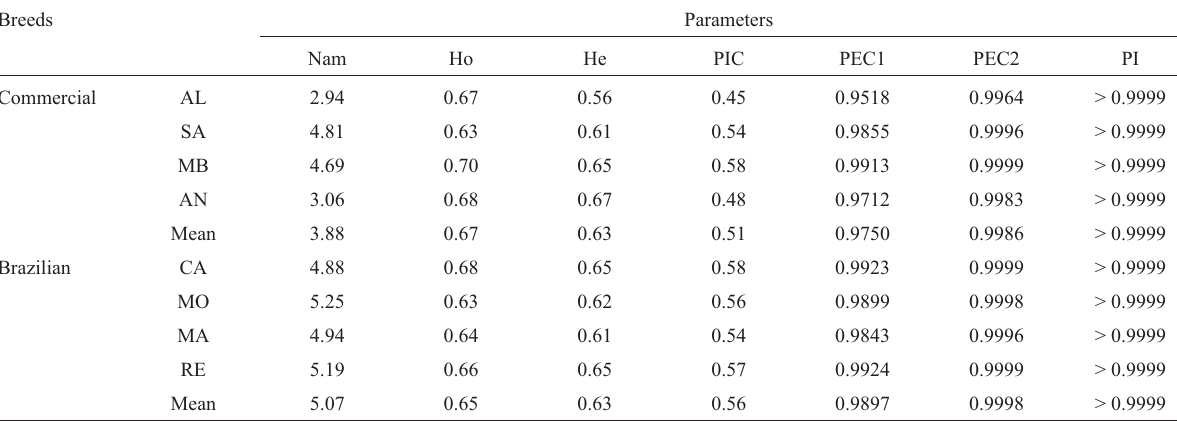
Table 4 - Genetic variability parameters estimates per breed using a panel of 16 microsatellite markers. Breeds